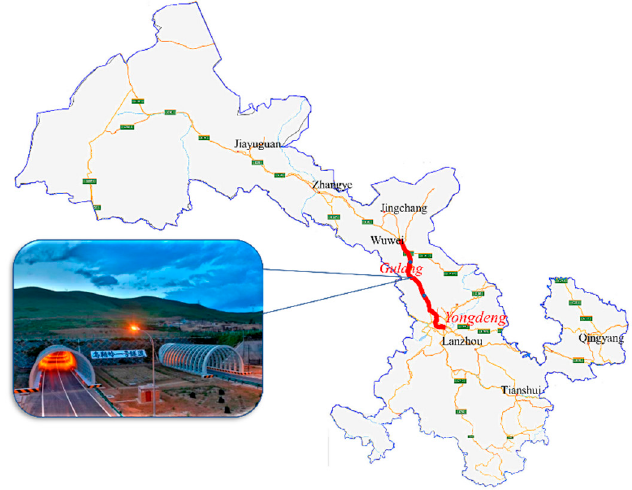
Figure 1. The location of the Wushaoling tunnel groups.